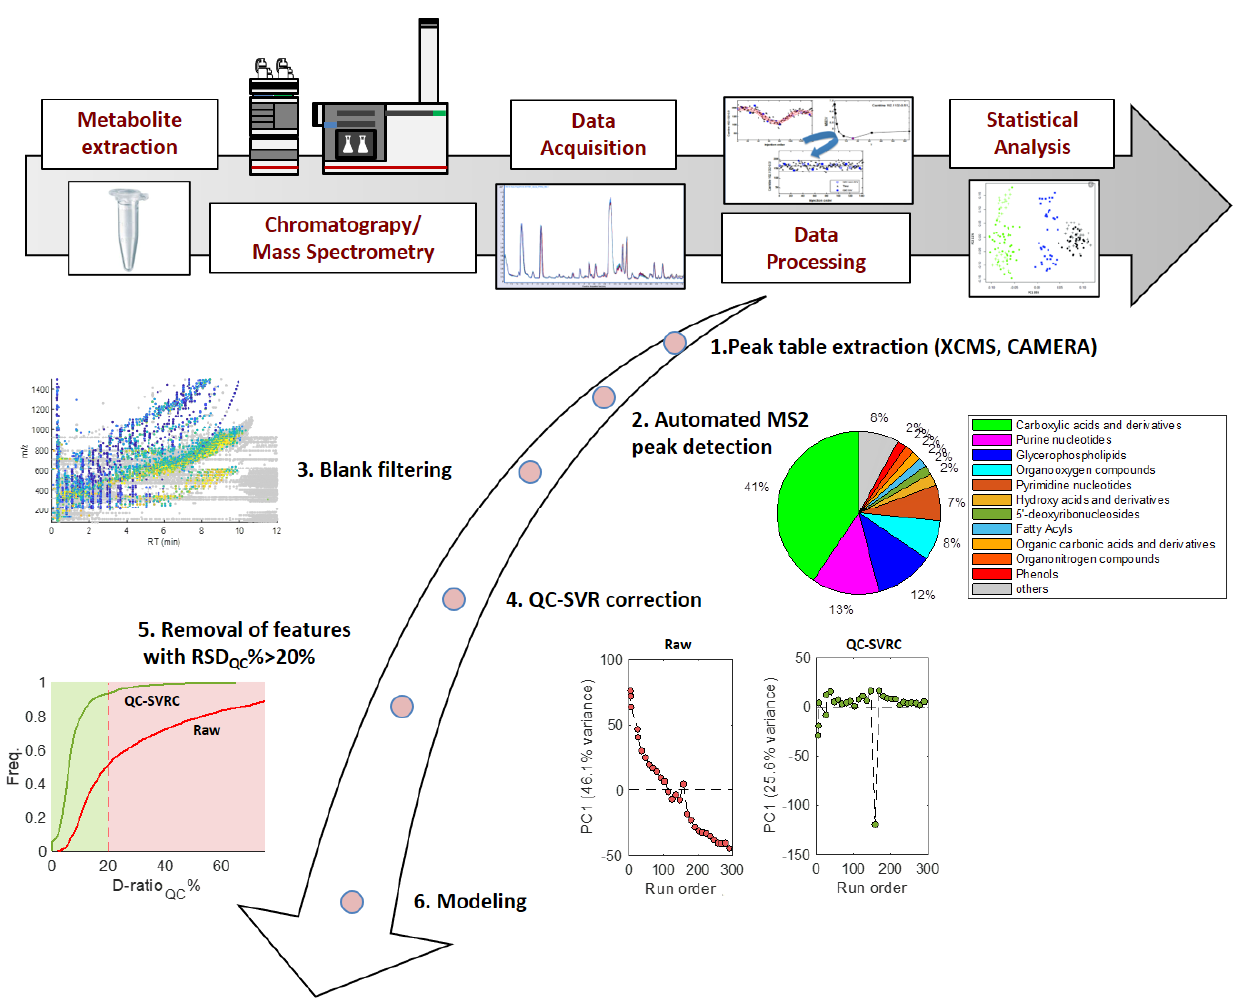
Figure 3. The overall workflow in metabolomic analysis. Robust data acquisition from DILI patients, normalisation and elimination of sources of variability and contamination are key for conclusive bioinformatic analysis that will allow identification of DILI